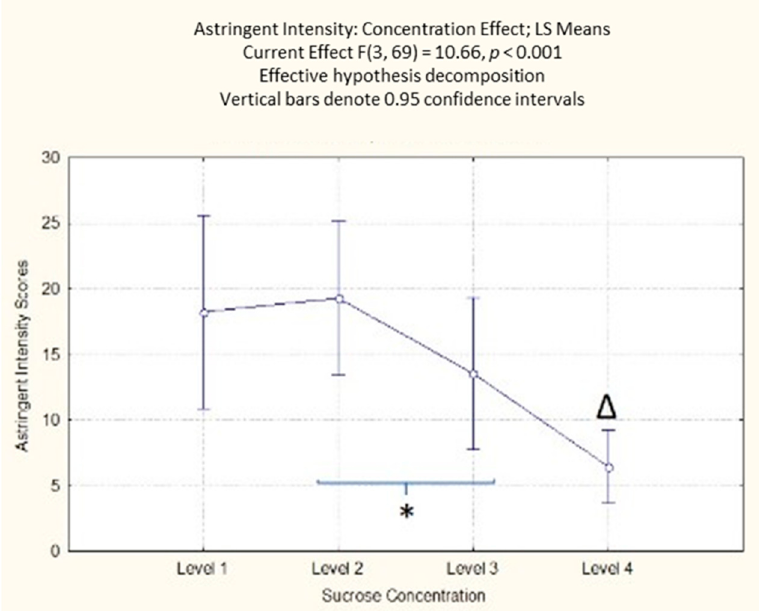
Figure 5. Concentration effect on perceived astringency responses with different sucrose concentra- tion levels. The order of the levels corresponds with the different sucrose amounts (38; 83; 119; 233 g/kg). * Denotes a significance level <0.05, while Δ indicates a significant difference from all other sucrose levels <0.001.